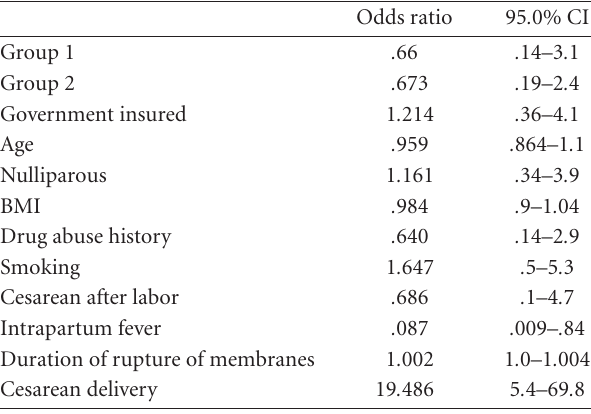
Table 4: Logistic regression modeling for risk factors for